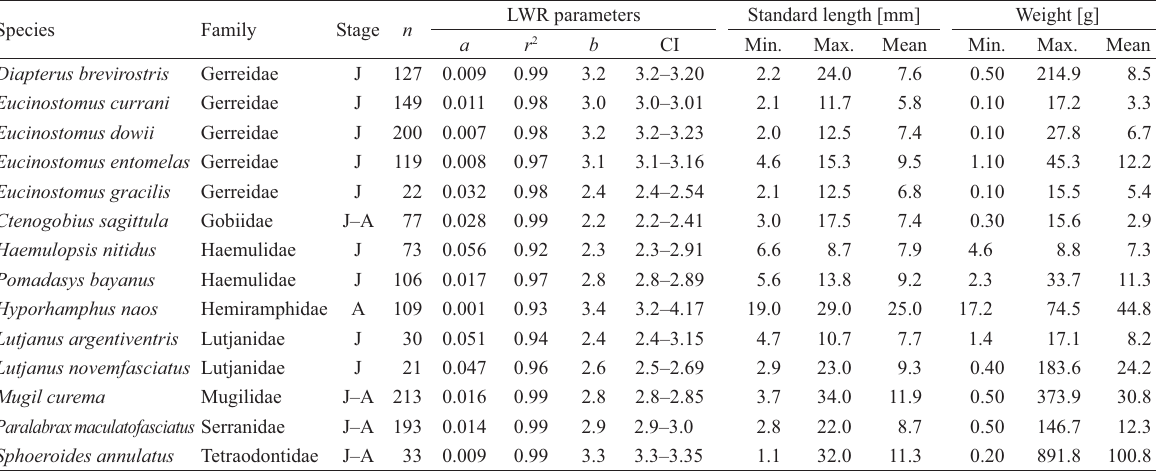
Length–weight relations (LWR) for 14 fish species caught in mangroves swamps of La Paz Bay, BCS,